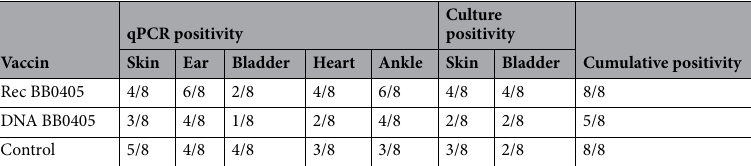
Table 1. Overview of number of Borrelia positive mice per group in qPCR tissues and culture. Each experimental group consisted of 8 mice. qPCR was performed on 5 different tissues: skin (tick bite site on the back), ear, bladder, heart and ankle. Both skin and half of the bladder were cultured in MKP medium and checked for growth of Borrelia for 8 weeks. Statistical significance of cumulative data of the experimental groups compared to the DNA Empty was calculated with the Fisher’s exact test. Comparison between all separate groups was not statistically significant.